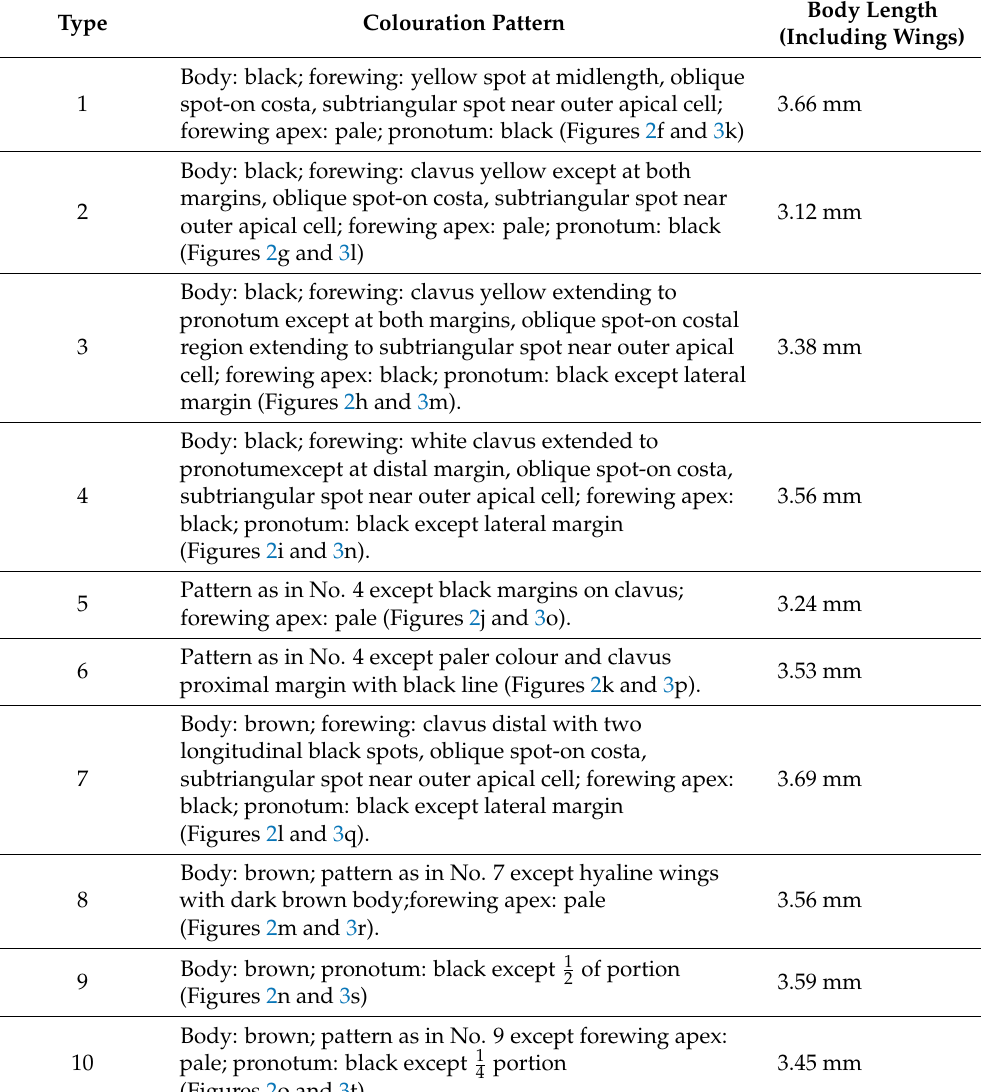
Table 4. Colour pattern and body length of females of M. splendida . Type Colouration Pattern